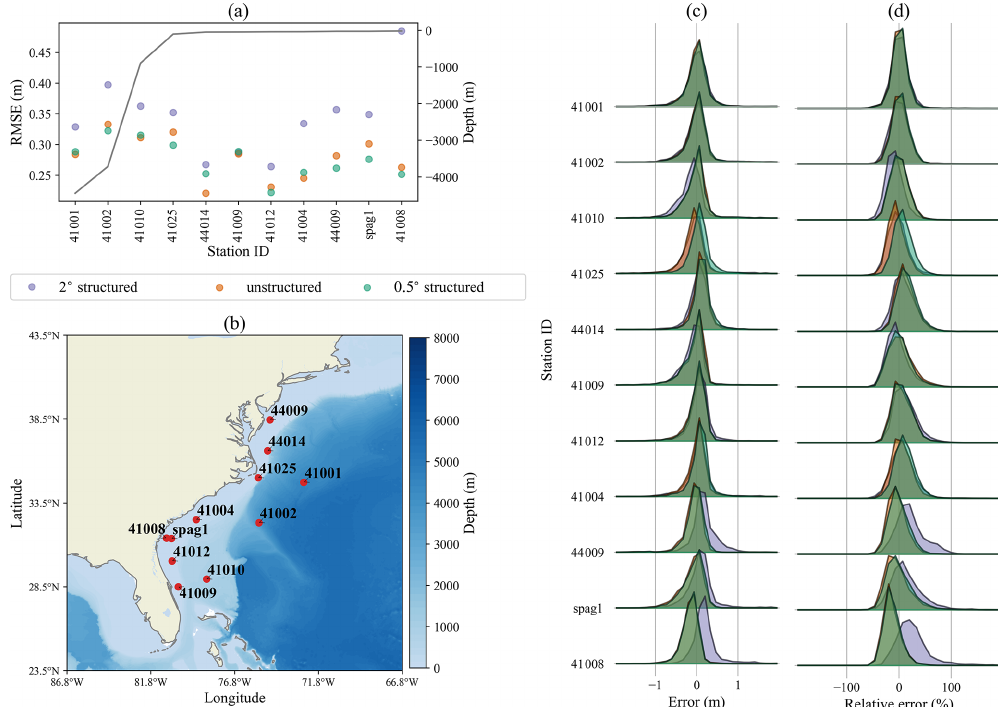
Figure 4. Same as Fig. 3 for stations in the southern to mid-Atlantic east coast.